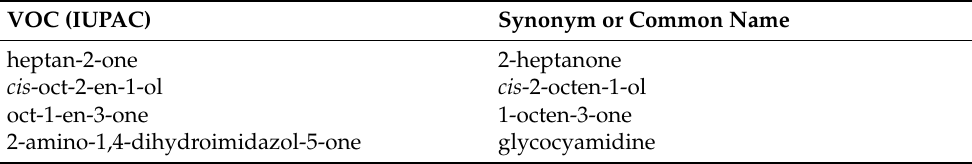
Table 4. VOCs to be investigated as potential biomarkers for aflatoxigenic